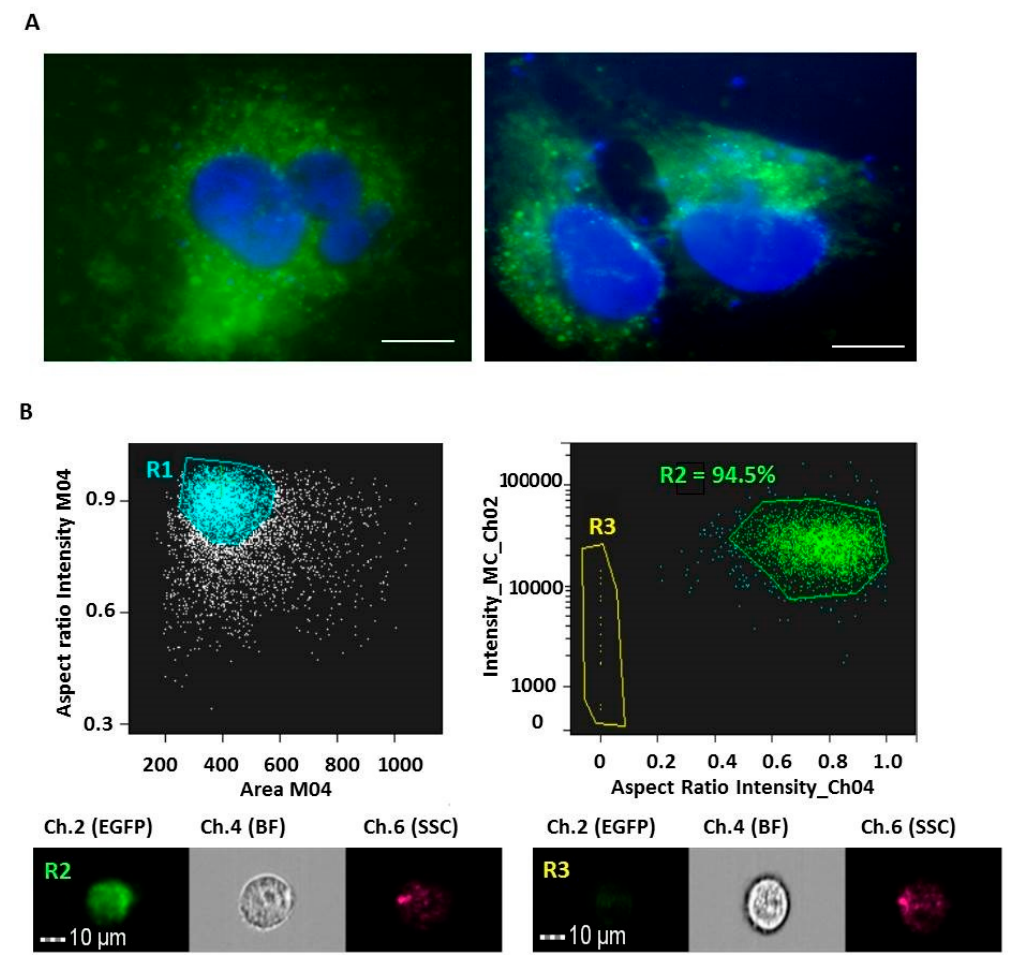
Figure 6. Fluorescence microscope and flow cytometric examinations of T98G cells after administration of electroporated membranes-generated vesicles (M-NVs, ~2 × 10 7 particles) with pEGFP vector (0.5 µ g). Cells (~2 × 10 3 ) were fixed after 72 h p.t, DAPI stained and visualized by fluorescence microscope (100 × magnification, scale bars = 10 µ m) ( A ). Amnis ImageStreamX MarkII flow cytometry analysis was used to quantify the uptake e ffi ciency (as percentage of fluorescent cells) of pEGFP electroporated M-NVs (~2 × 10 7 particles) into T98G cells (~5 × 10 6 ). As a result, R1 single cells subpopulation ( n = 5000) showed a 94.5% of green fluorescent signals ( R2 ). R2 and R3 representative cells were visualized using 40 × magnification ( B ).